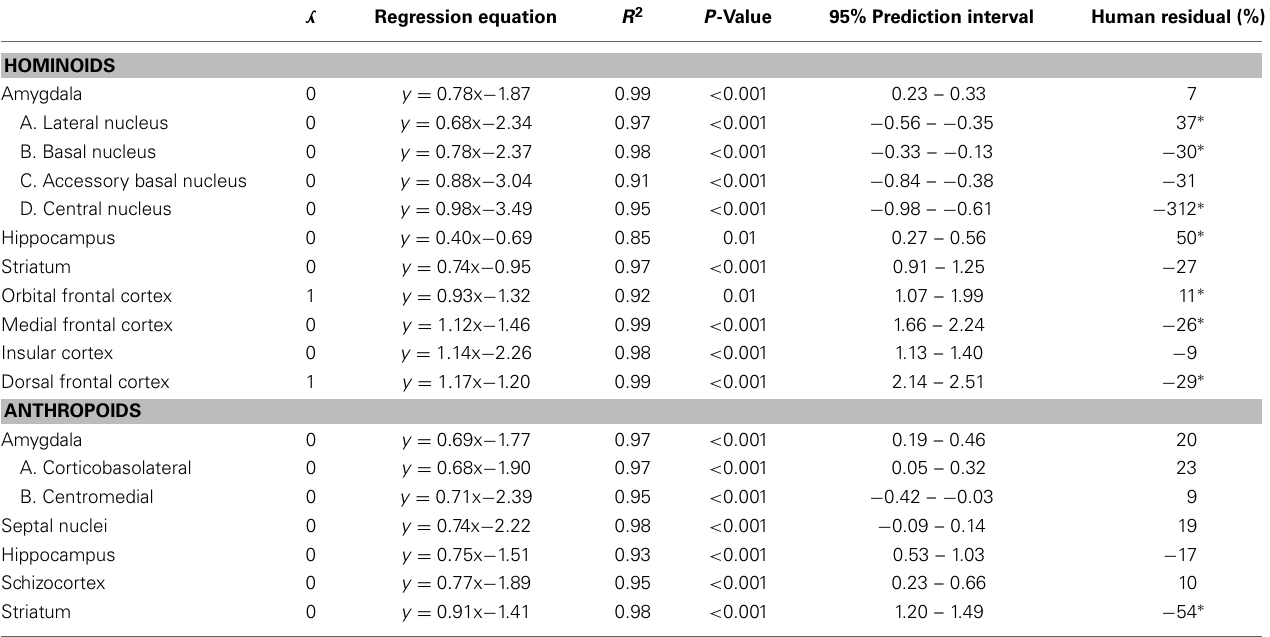
Table 5 | Results of regression analyses run through hominoid and anthropoid